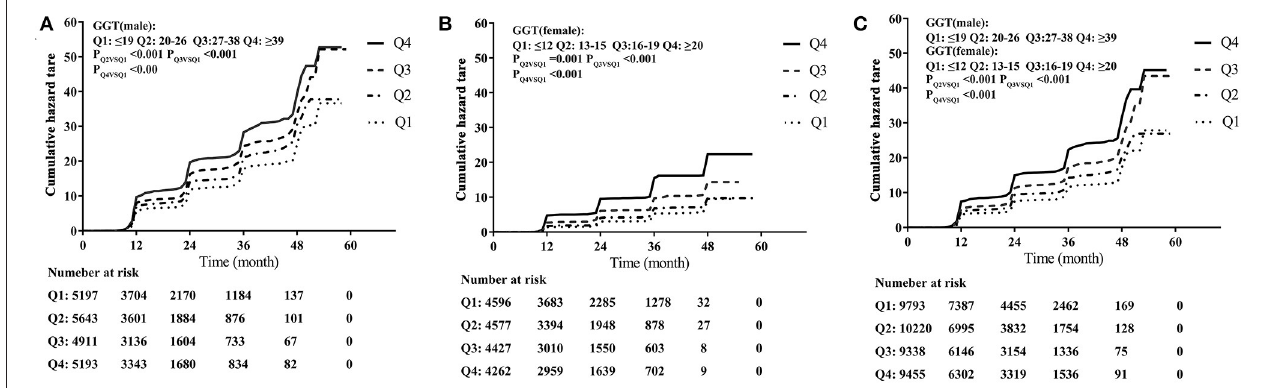
FIGURE 1 | Incidence of hypertension stratified by sex-specific quartiles (Q) of serum gamma-glutamyltransferase (GGT) levels. (A) Incidence of hypertension in 20,944 males. (B) Incidence of hypertension in 17,862 females. (C) Incidence of hypertension in a total of 38,806 participants.